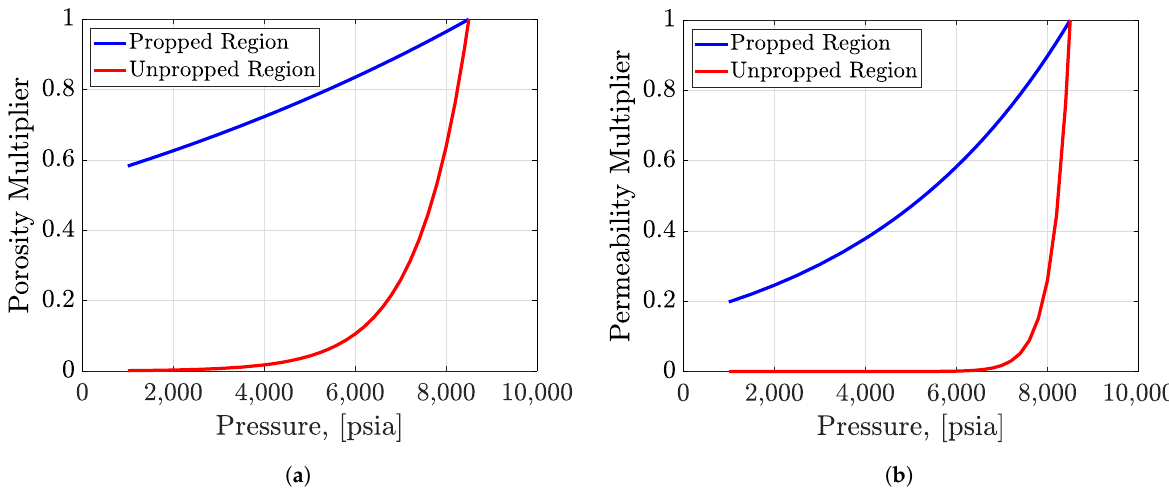
Figure 4. Compaction curves for the propped (blue line) and the unpropped (red line) zone of the hydraulic fractures, ( a ) Porosity multipliers and ( b ) Permeability